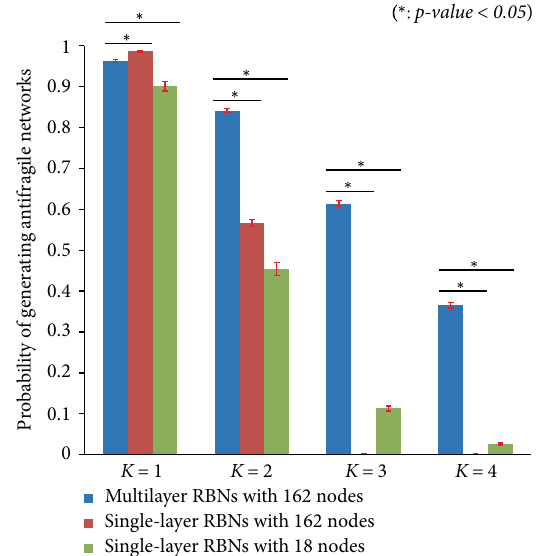
Figure 7: Comparison between multilayer and single‐layer RBNs based on the probability of generating antifragile